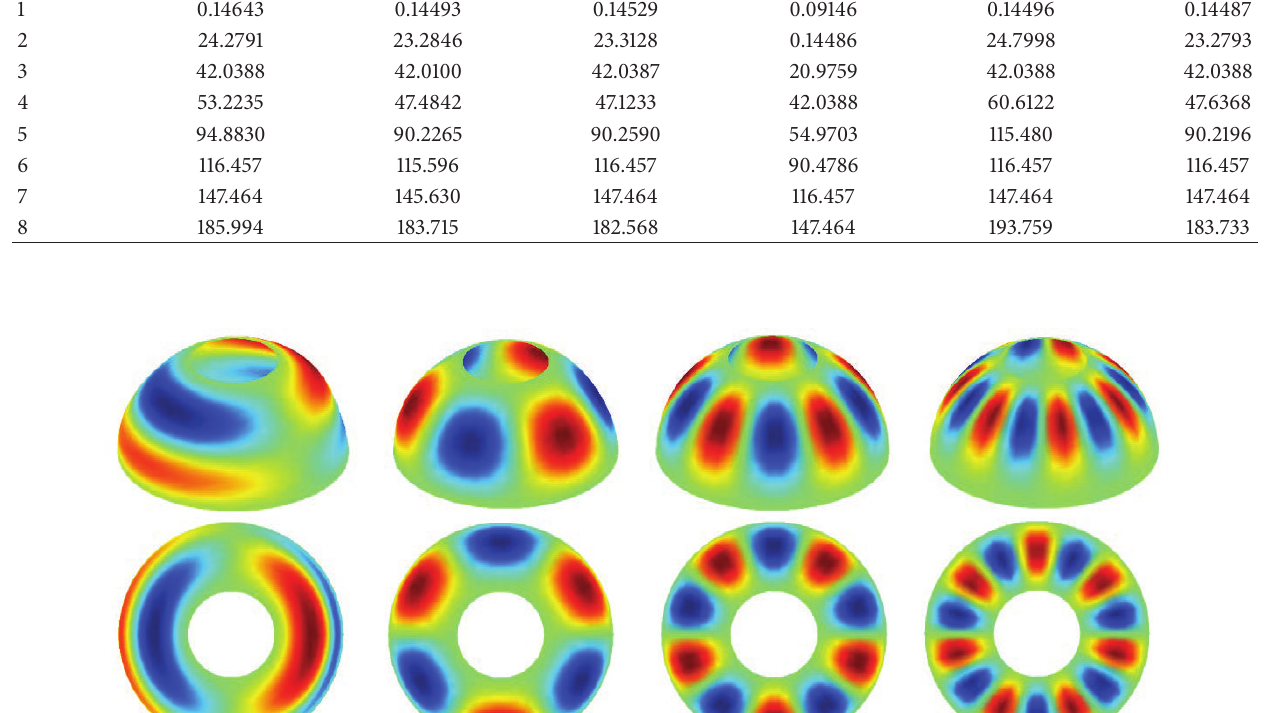
Table 23: First eight frequencies (Hz) for a closed spherical shell with single point classically and elastically supported at each end. Modes